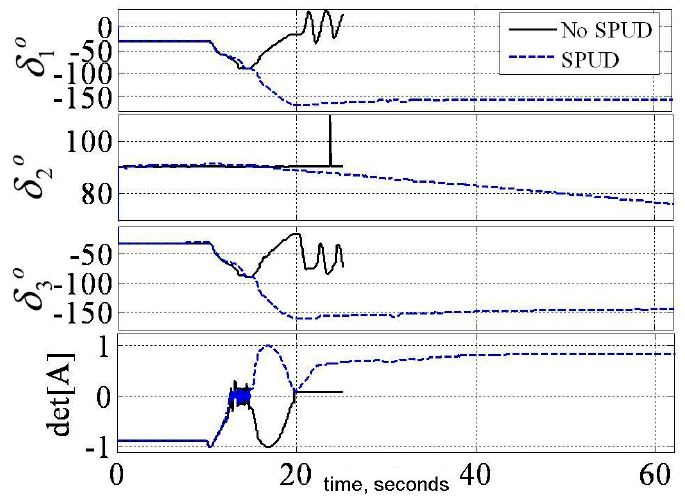
Figure 13. EXPERIMENTATION: Gimbal angles (top) and det[A] (bottom) versus time (seconds) associated with Figure 12.